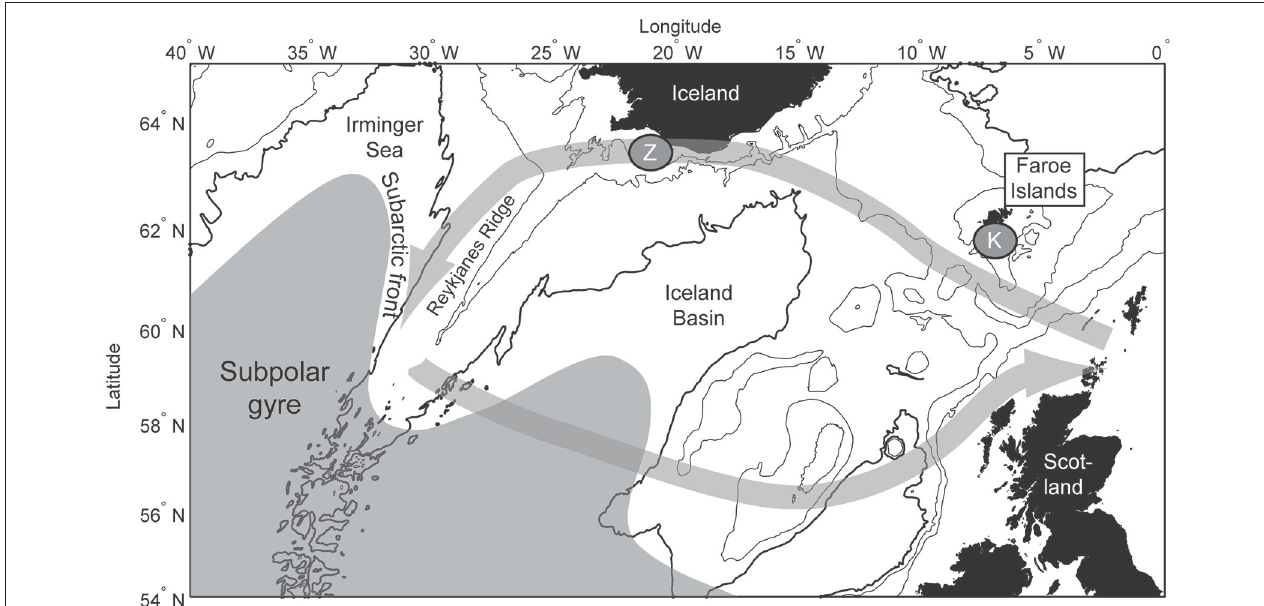
FIGURE 1 | Map of the northeastern Atlantic Ocean. The subpolar gyre is illustrated in gray, and the pre-breeding kittiwake feeding excursion is shown with the gray arrows. The Faroe kittiwake breeding success is sampled at site “K,” and the Icelandic zooplankton record is sampled at site